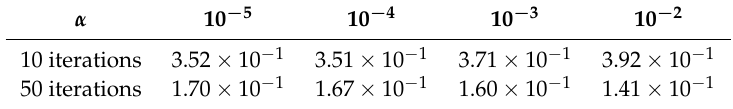
Table 2. The error (cid:107) ξ ( 1 ) − ξ p (cid:107) depending on the stopping criterion and regularization parameter α L W 2 ( Γ op )